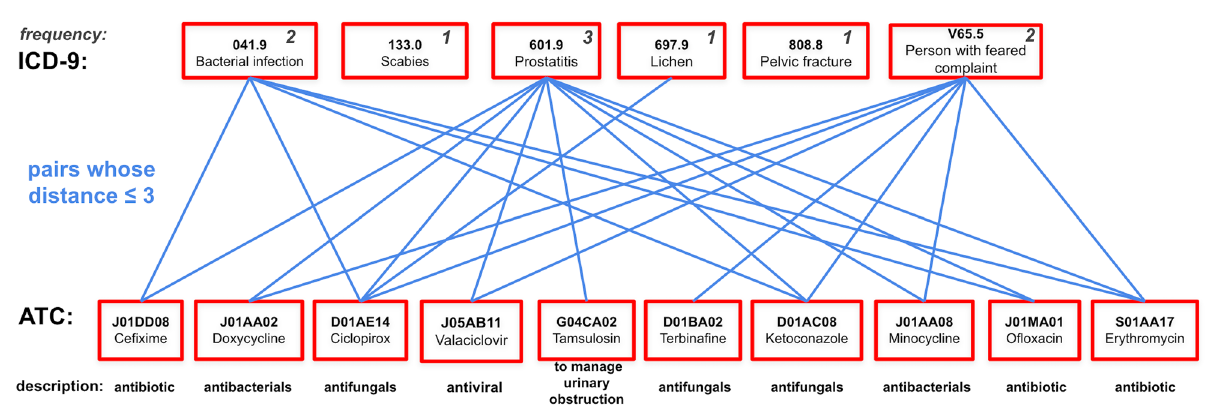
Figure 6. The connection between the observed ICD codes and the imputed ATCs of patient e shown in Fig. 4. ICD-ATC pairs whose distances are no more than 3 are linked. We observed that the imputed ATC codes are closely connected to observed ICD codes. The within-patient frequency for each ICD code is annotated. Short descriptions are provided for each of the imputed ATC codes at the